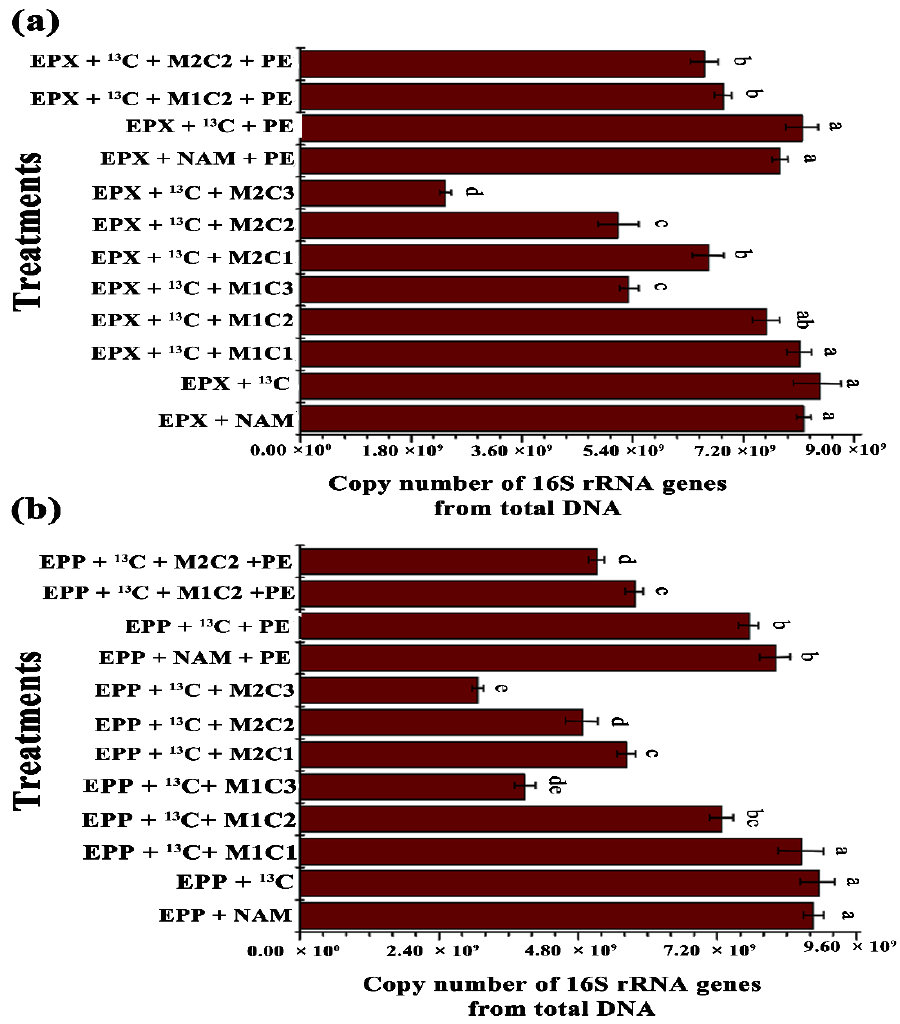
Figure 6. Relative abundance of 16S rRNA genes from total DNA: copy numbers of 16S rRNA genes abundance of ( a ) epixylon and ( b ) epiphyton from total DNA. The data in a column with a different letter differ significantly at Duncan’s significance level 0.05.